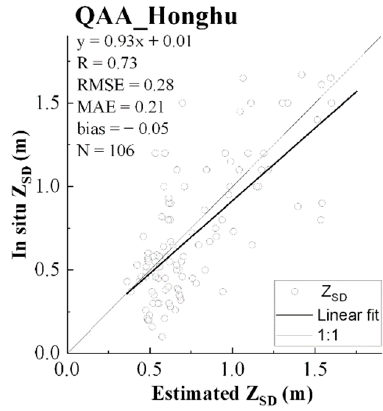
Figure 6. Scatter plots of Landsat-estimated Z SD and in situ-measured Z SD for QAA_Honghu. The field data were gathered ±1–7 days of Landsat satellite overpass.